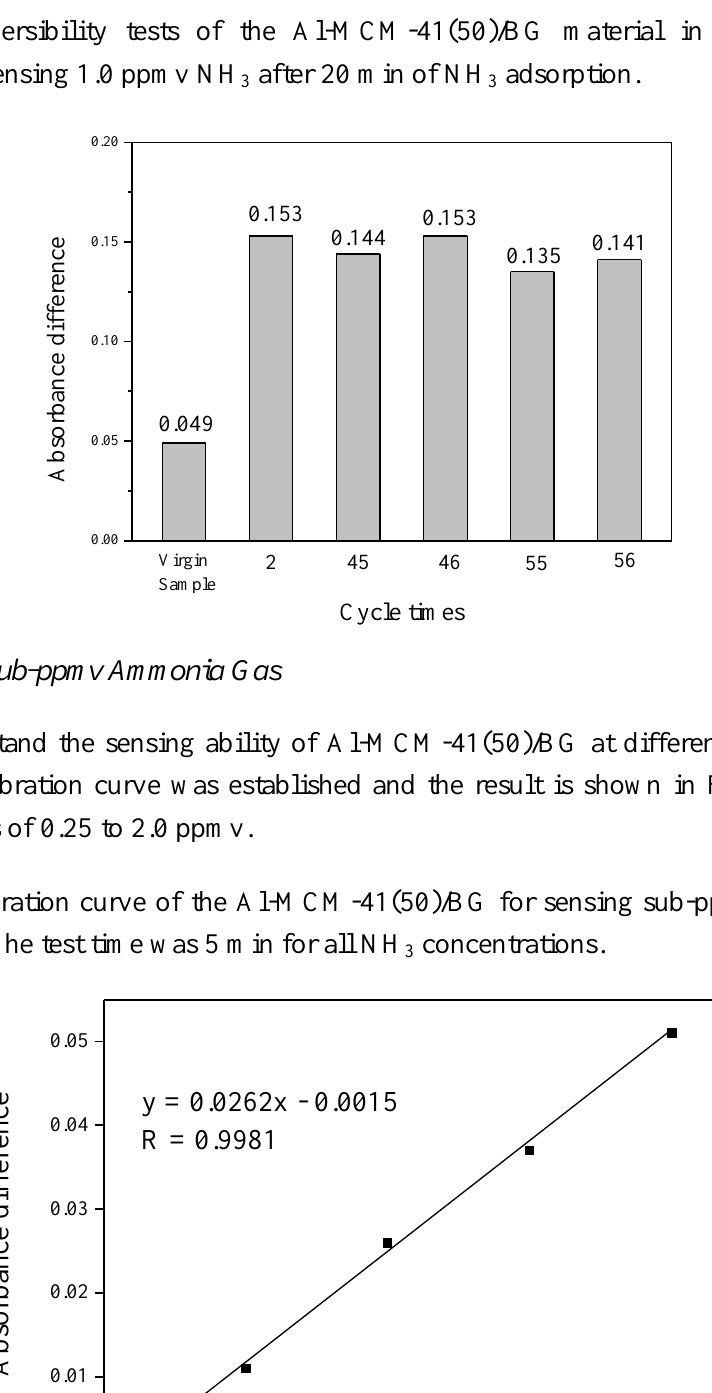
Figure 7. Reversibility tests of the Al-MCM-41(50)/BG material in the absorbance difference for sensing 1.0 ppmv NH